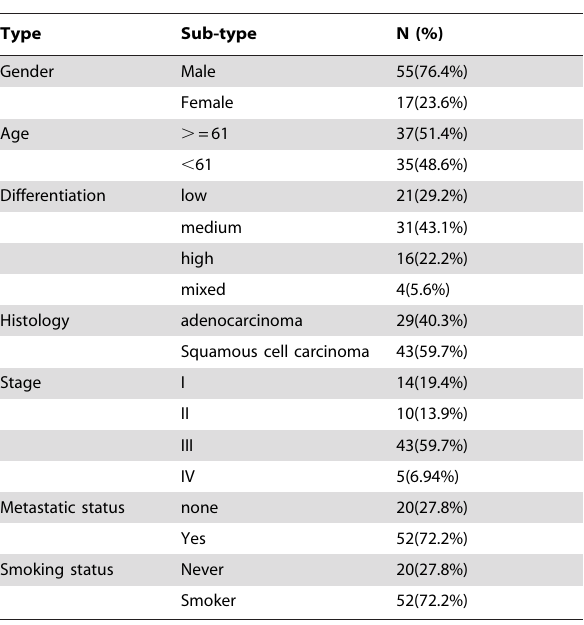
Table 1. Patient